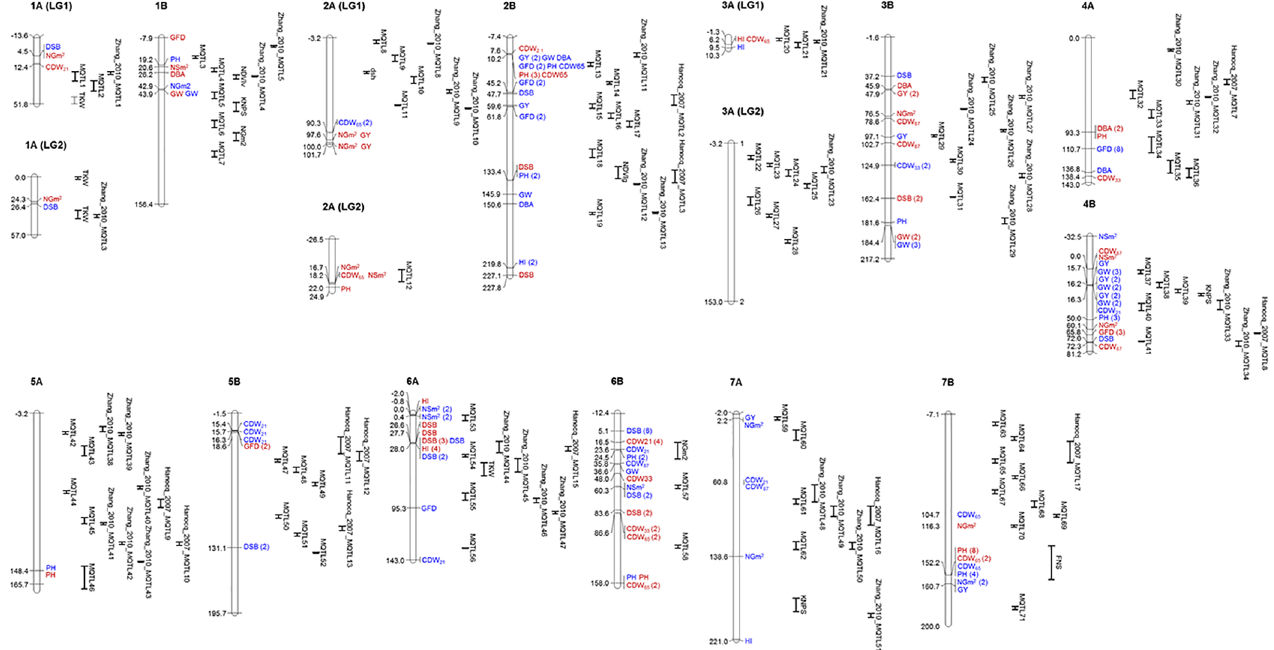
Fig 1. Genetic map for significant MTAs. Genetic position in the durum wheat consensusmap from Maccaferri et al. [36] of significantMTAs in the north (blue) and south (red) Spanishlocationstogetherwith the position of MQTLs reportedin this study and by other authors [24, 25]. Numbers in parenthesis after MTAs represent the numberof different MTAs for the trait. When a MQTL involvedonly one QTL, it is reportedas the trait for that QTL. For the extendedname of the traits, see the list of acronyms.